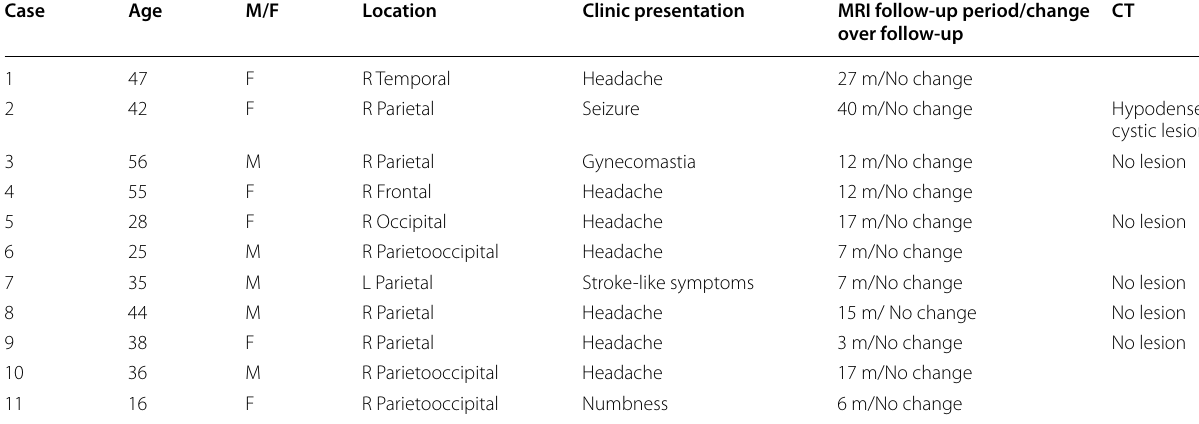
Table 1 Patients demographics, clinical data and imaging